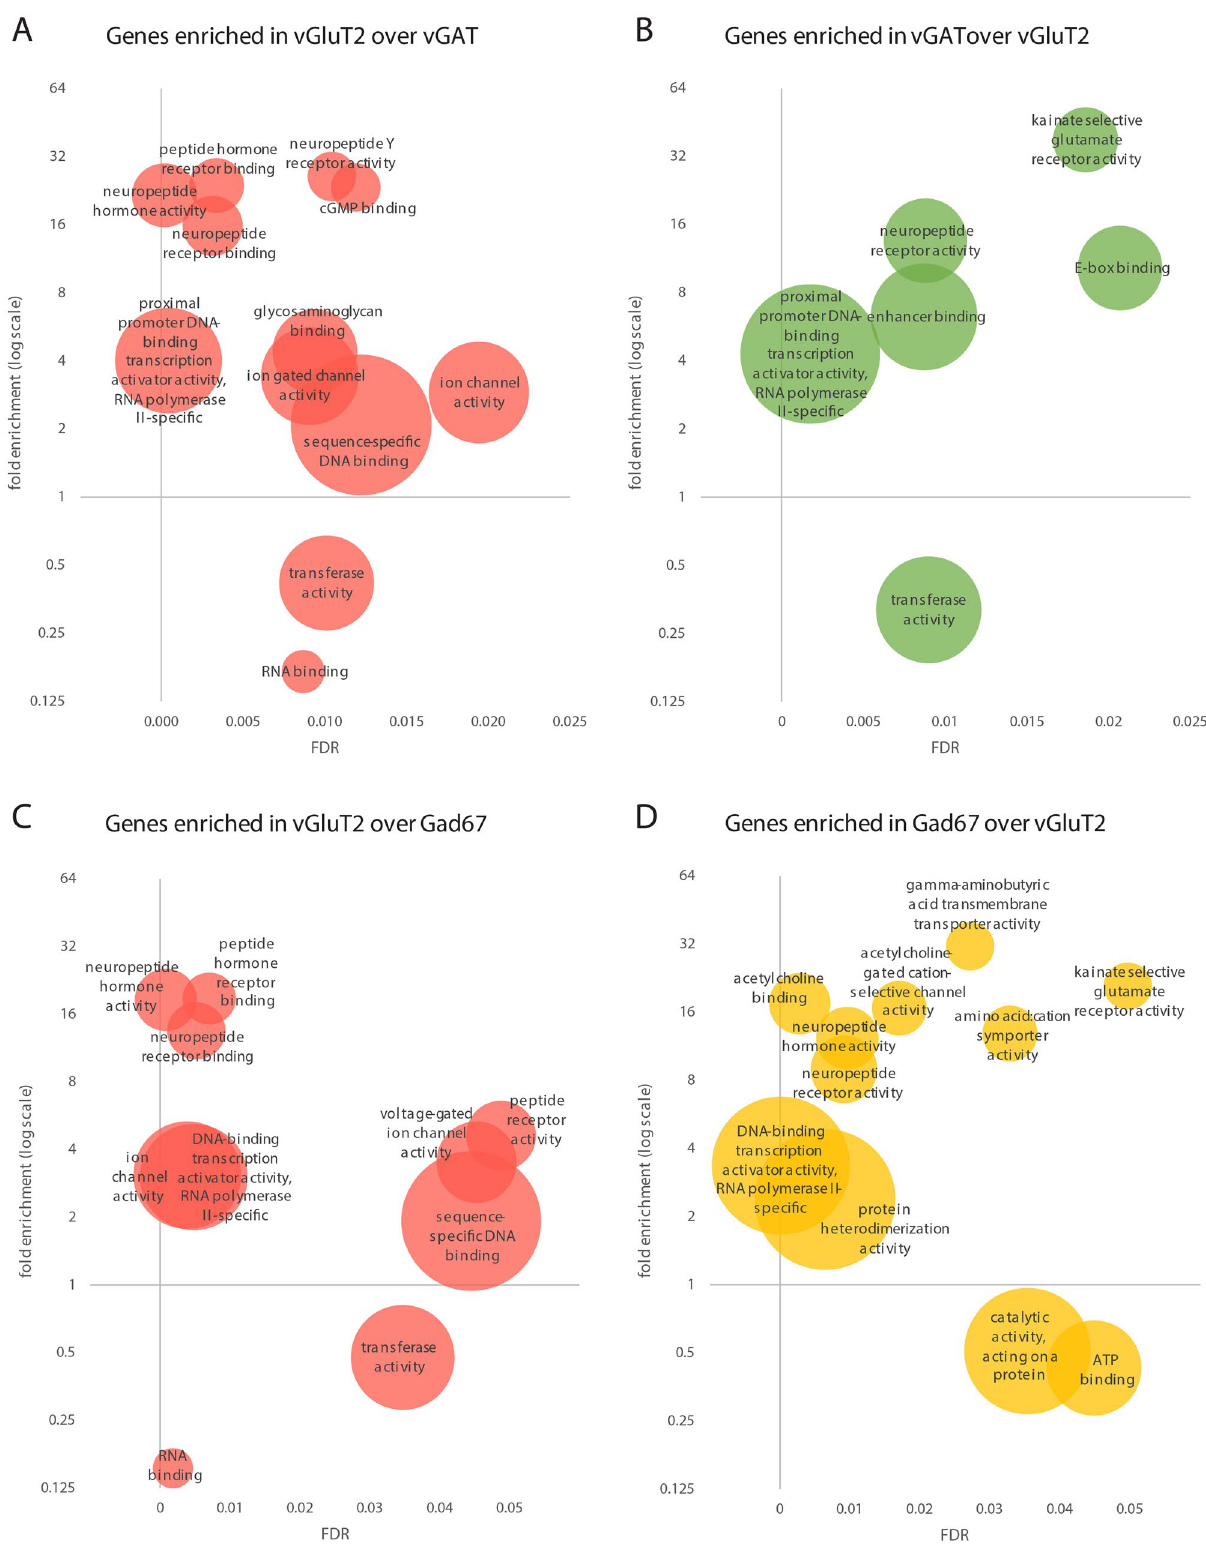
Figure 3. GO term overrepresentation analyses for the molecular function (MF) with the enriched genes in the comparison of vGluT2::bacTRAP to vGAT::bacTRAP and Gad67::bacTRAP. Overrepresented MF GO terms in the genes enriched in the comparison of ( A ) vGluT2 vs. vGAT, ( B ) vGAT vs. vGluT2, ( C ) vGluT2 vs. Gad67 and ( D ) Gad67 vs. vGluT2. ( A – D ) x axis displays false discovery rate (FDR) of the overrepresented GO term, y axis displays fold overrepresentation on a logarithmic scale and circle size indicates number of enriched genes. When several GO terms of a hierarchy are significantly overrepresented, only the most specific GO term is displayed. ( D ) For comprehensibility two MF are not displayed: “acetylcholine receptor activity”, 13.12-fold enrichment, FDR = 0.00801, no of enriched genes = 5, and “RNA polymerase II proximal promoter sequence-specific DNA binding” 2.79-fold enrichment, FDR = 0. 0.000603, no of enriched genes =